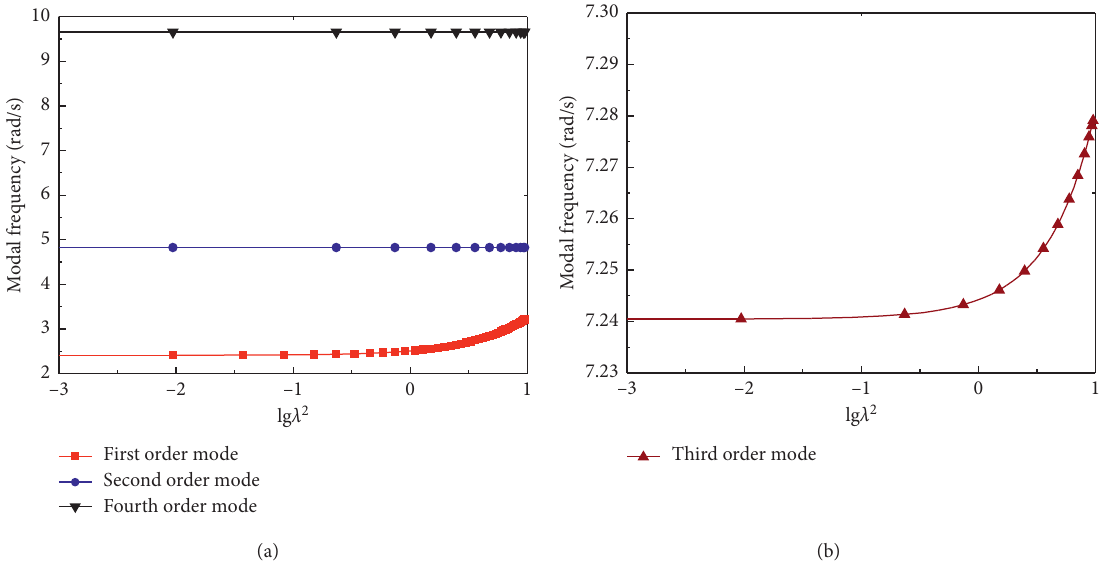
Figure 8: Relationship between in-plane modal frequency and sag of tether.